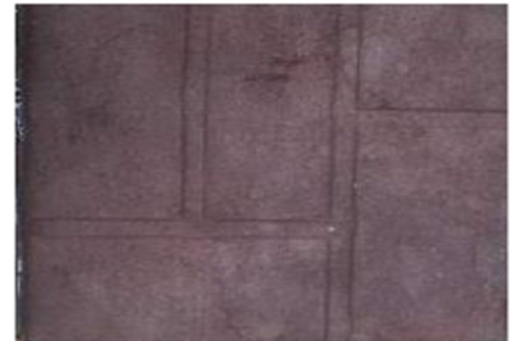
Fig. 1 Pavement block made of plastic waste (Source: Quartz